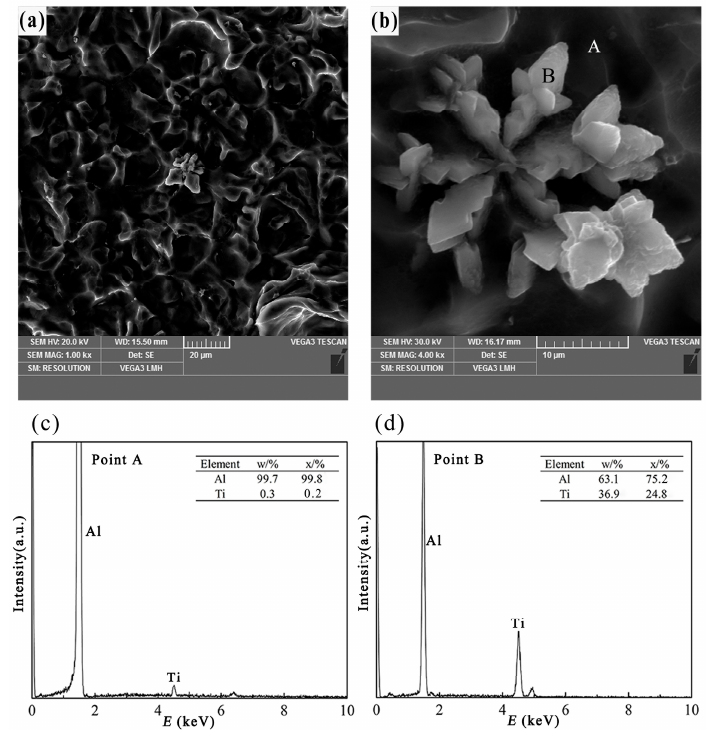
Figure 6. Three-dimensional morphology and point scan elements analysis of petal-like TiAl 3 , ( a , b ) three-dimensional morphology of the petal like TiAl 3 particle; ( c ) EDS spectra of point A; ( d ) EDS spectra of point B.